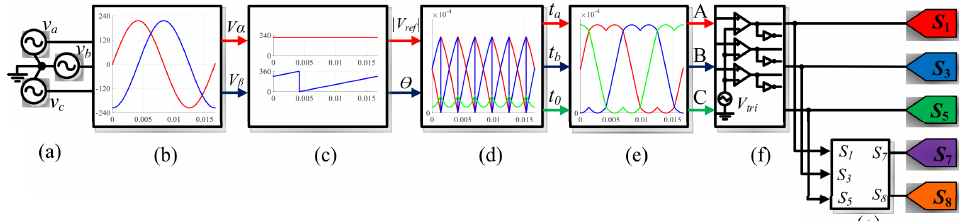
Figure 7. Block diagram of the implemented system in the PSIM software: the block ( a ) represents the three-phase signals; ( b ) is the Clarke transformation; ( c ) is the module and angle of the reference vector; ( d ) is the time vectors calculation; ( e ) reference signals for space vectors; and ( f , g ) represent the PWM signal generation.